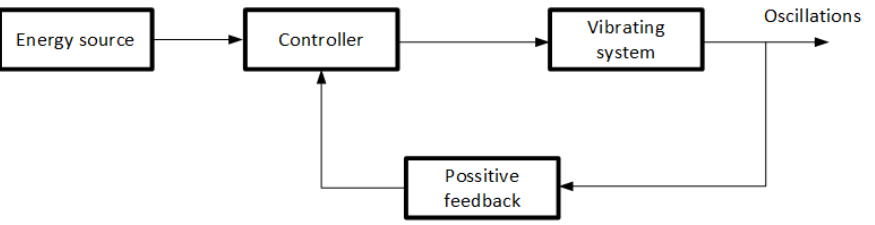
Figure 1. Block diagram of self-excited